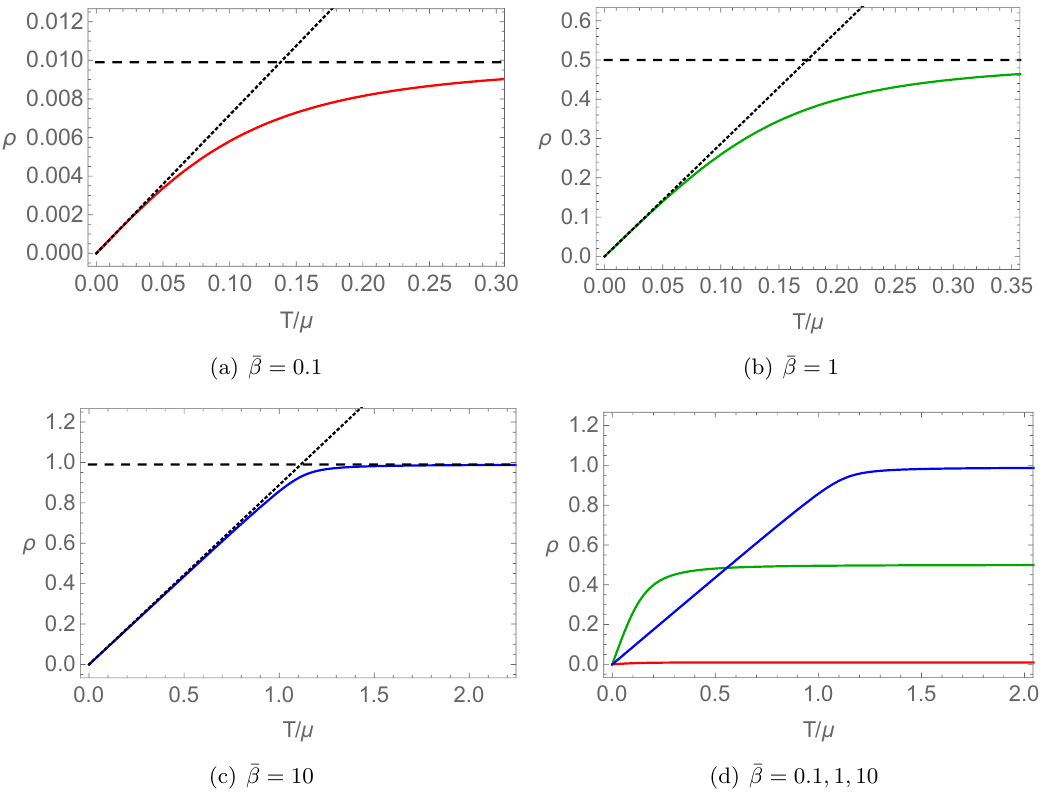
Figure 2 . Resistivity vs temperature at (cid:12)xed (cid:22) (cid:12) = 0 : 1 ; 1 ; 10. The horizontal dashed lines are the inverse of (2.16). The dotted lines are (2.19) (a), the inverse of (2.15) (b) and the inverse of (2.18)